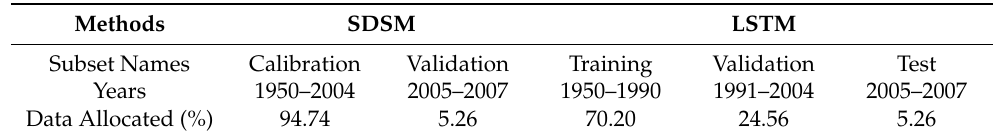
Figure 1. ( a ) Location of Lake Chad within Niger, Nigeria, Cameroon, Chad and their position in relation to Africa. ( b ) The zoomed LCB with riparian countries, where C.A.R stands for the Central African Republic. ( c ) The major and secondary water courses that feed lake Chad, neighbouring permanent water bodies and dams used for irrigation/domestic supply, local city names and locations with over 100,000 inhabitants (location only for cities with fewer than 100,000 inhabitants), irrigation areas and relative field sizes as well as common agricultural crops grown in the region, as well as the precipitation gauges considered in the study. Table 1. Data subsets for the purpose of comparison between SDSM and LSTM implementation in the Lake Chad Basin. The validation set of the SDSM implementation correspond to the test set of the LSTM